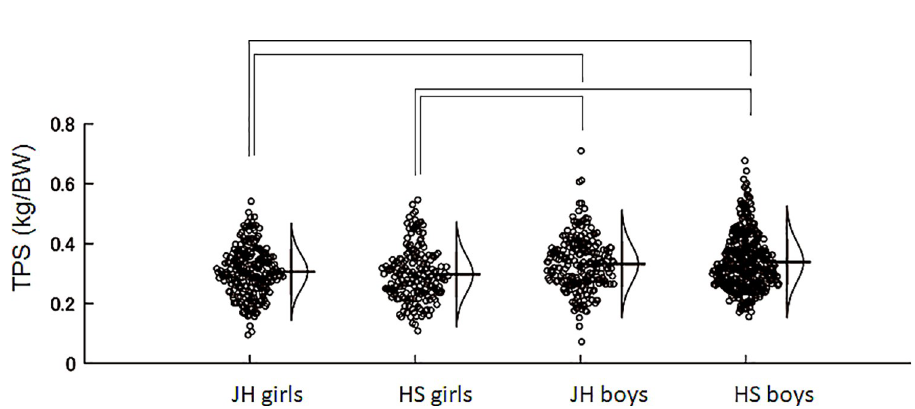
Fig 2. Jitter plots of the toe push strength per body weight for each group. The curves on the right side of the plots indicate the estimated gaussian distribution of each group. All brackets indicate significant difference between groups. Post-hoc tests revealed significant differences between sexes, but no significant differences between age groups. JH: junior high school, HS: high school, TPS: toe push strength.